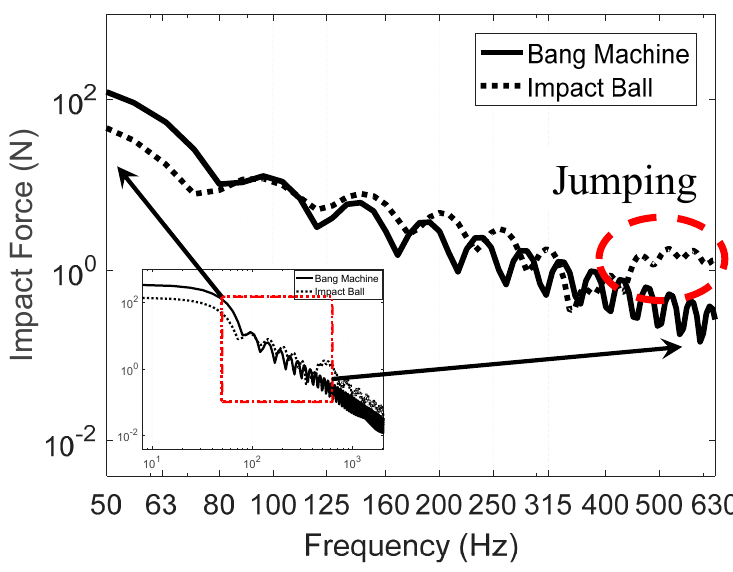
Figure 14. Two floor impact sources.